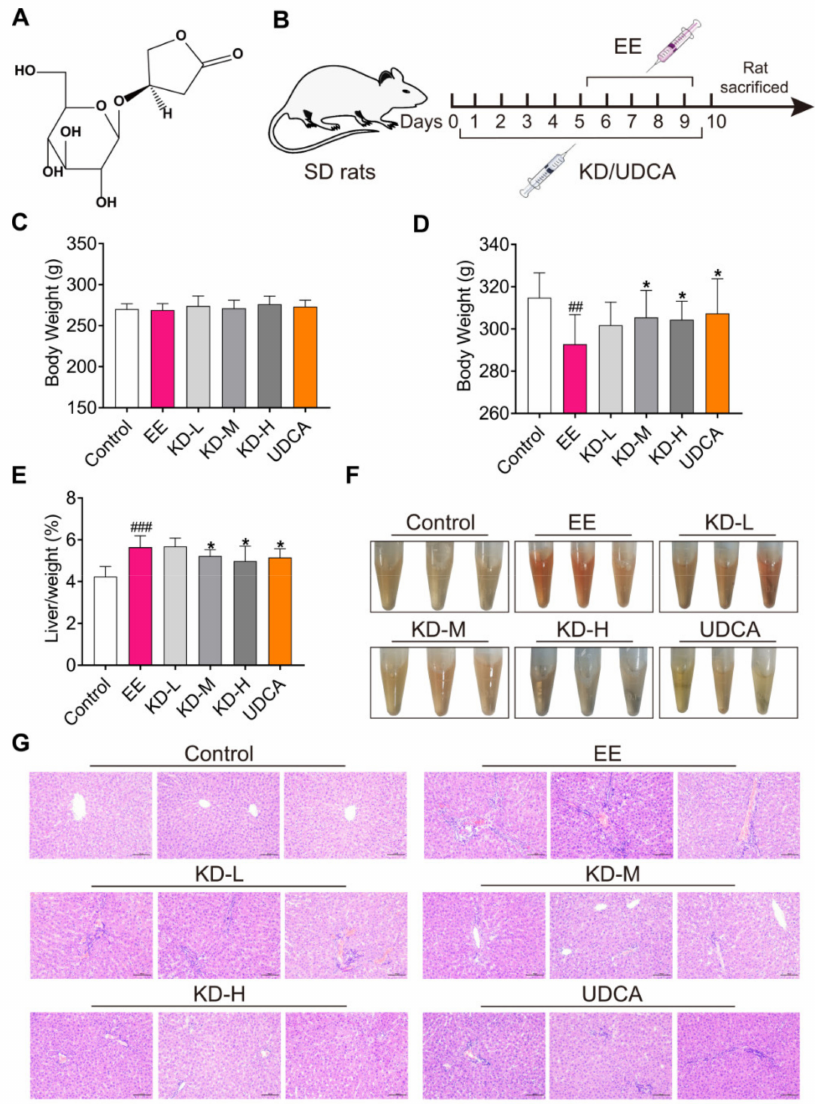
Figure 1. The therapeutic effect of KD on EE-induced cholestatic liver injury in rats. ( A ) The chemical structure of Kinsenoside (KD). ( B ) Schematic of the experiment. ( C ) The body weight of rats in each group before KD or UDCA treatment. ( D ) Changes in body weight of rats in each group at the end of KD or UDCA administration. ( E ) The ratio of liver weight to body weight in each group was measured when rats were sacrificed. ( F ) Representative images of phenotype of serum from each group were exhibited after receiving KD-L, KD-M, KD-H and UDCA treatment, respectively. ( G ) Pathological images of liver in each group were analysed by hematoxylin and eosin (H&E) staining. Scale bar, 100 µ m. In ( C – E ), data are presented as mean ± SD ( n = 10). ## p < 0.01 and ### p < 0.001 denote statistical significance, compared to the control group. * p < 0.05 denotes statistical significance, compared to the EE